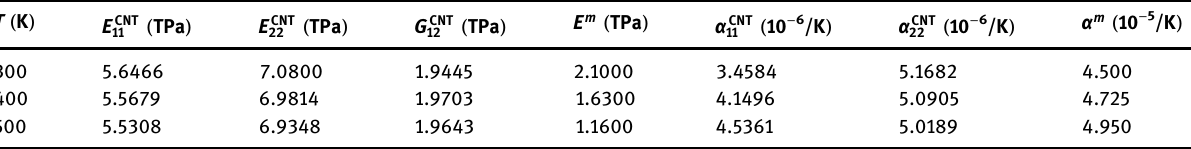
Table 1: Temperature - dependent properties of CNT/PmPV ( = v 0.175 12